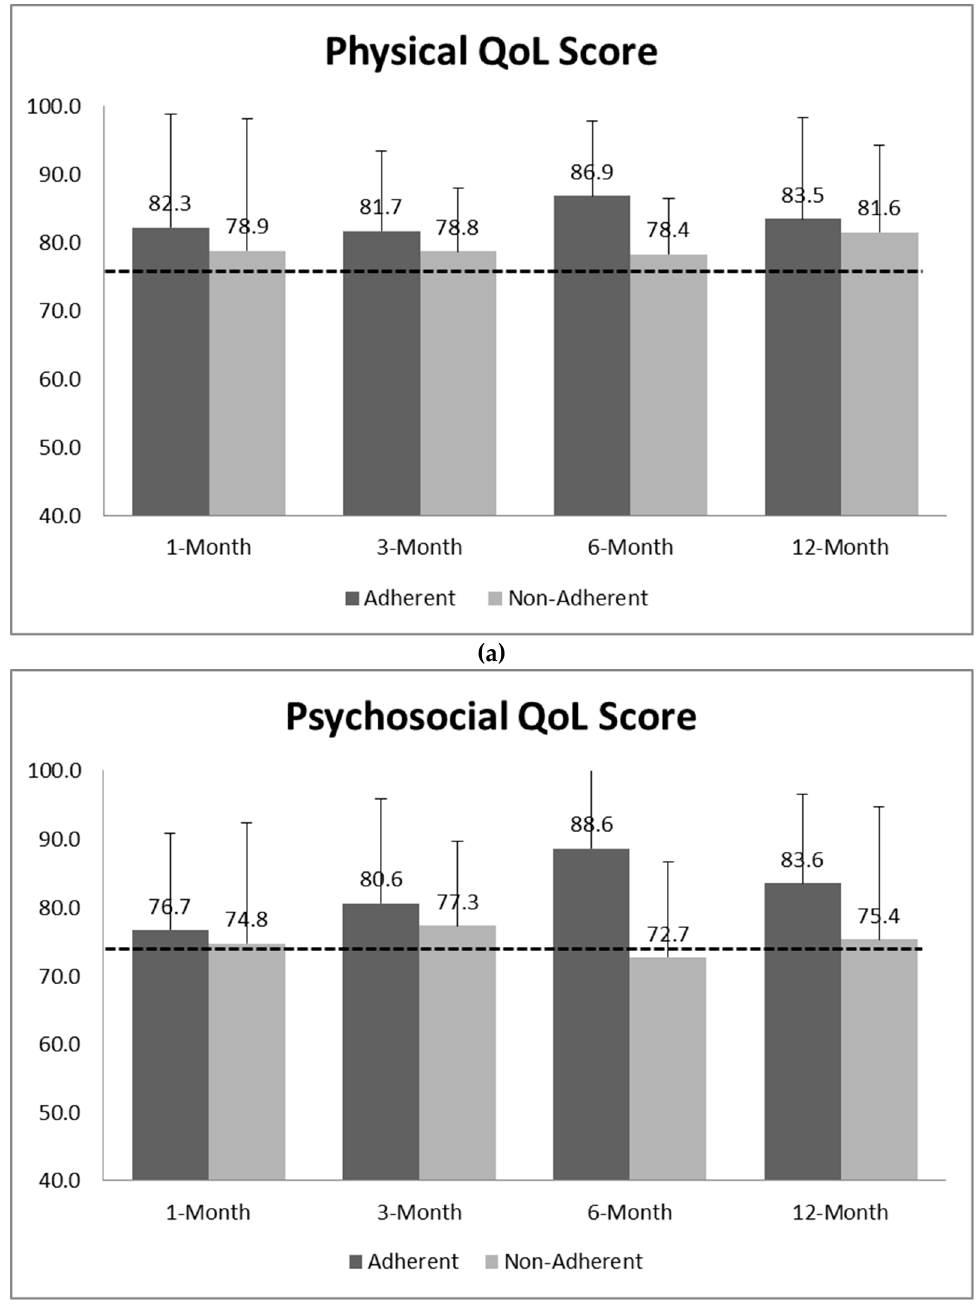
Figure 4. Participant-reported physical ( a ) and psychosocial ( b ) HRQOL by adherence (Dotted lines: Mean score at baseline) .